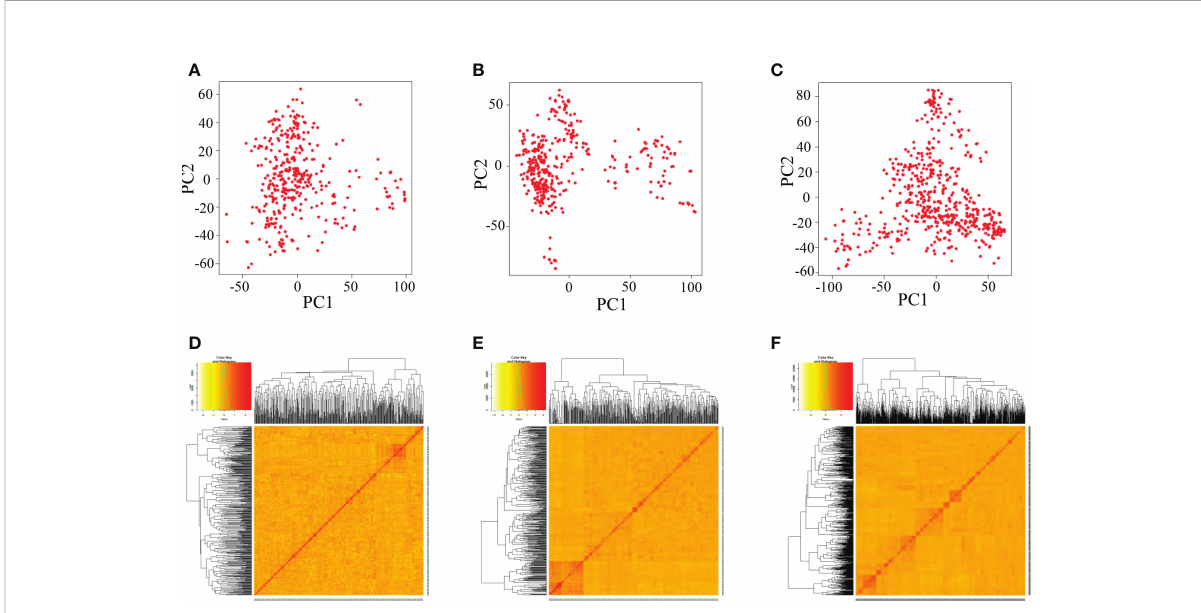
FIGURE 3 Analysis of the population structure of three populations by GAPIT. (A – C) Indicate the PCA plots of DC1, DC2 and 8way, respectively; (D – F) indicate the kinship matrix of DC1, DC2 and 8way, respectively.